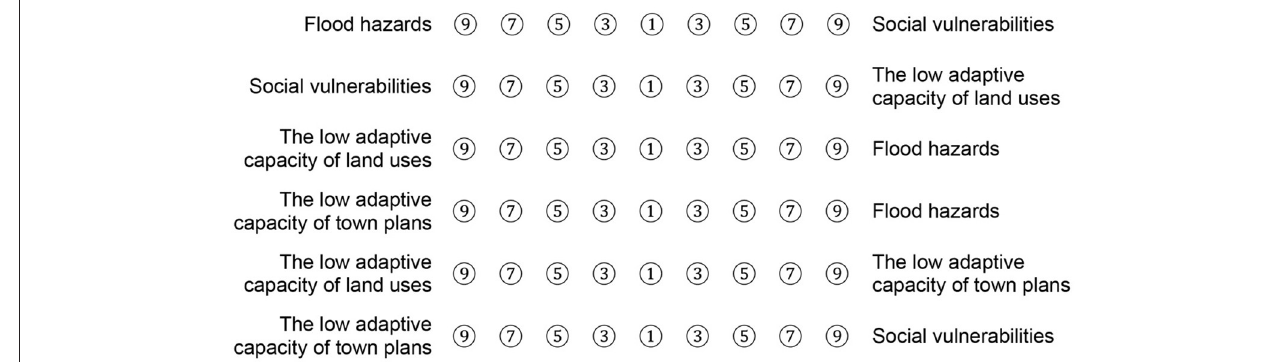
FIGURE 2 | Concepts’ weightings through AHP approach.